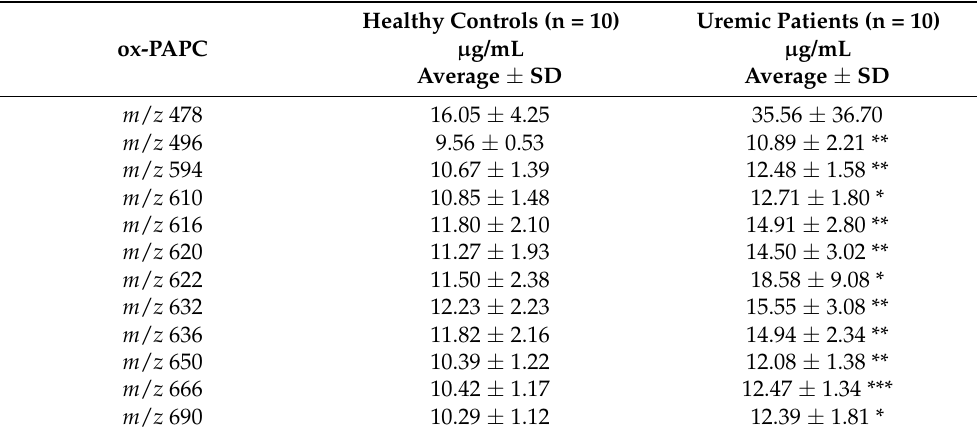
Table 2. Short-chain ox-PAPC product concentrations in VLDL of healthy controls and uremic patients.